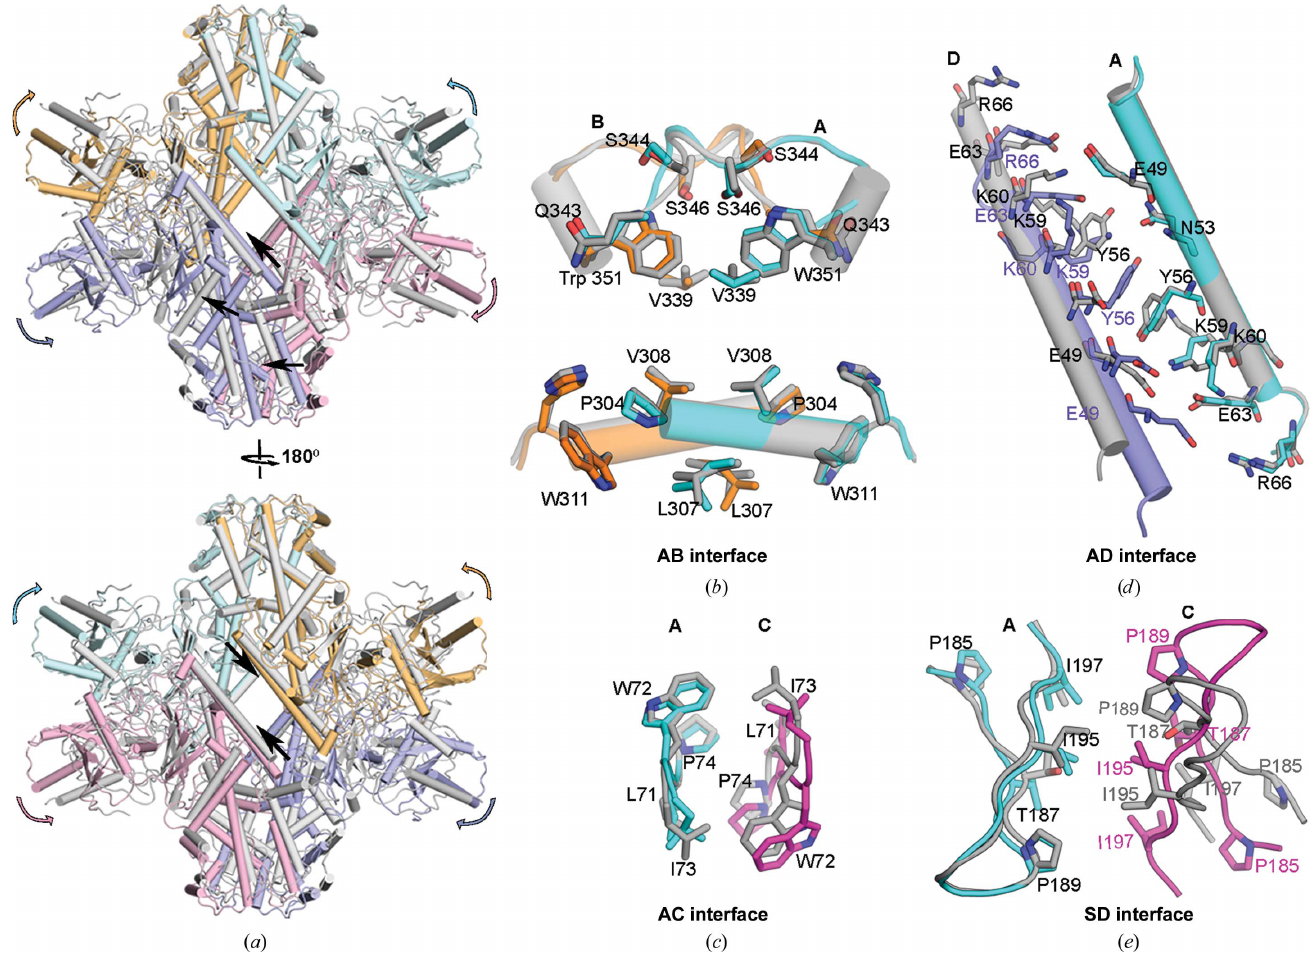
Figure 4 Structural comparison between PvHK conformational states. ( a ) Superposition of open (I) and closed (II) states of the PvHK tetramer. Open-state protomers are shown in four different colors, while the corresponding protomers in the closed state are shown in gray. Superposition of the residues at the ( b ) AB, ( c ) AC, ( d ) AD and ( e ) SD interfaces highlight the relative changes in the open (colored) and closed (gray)